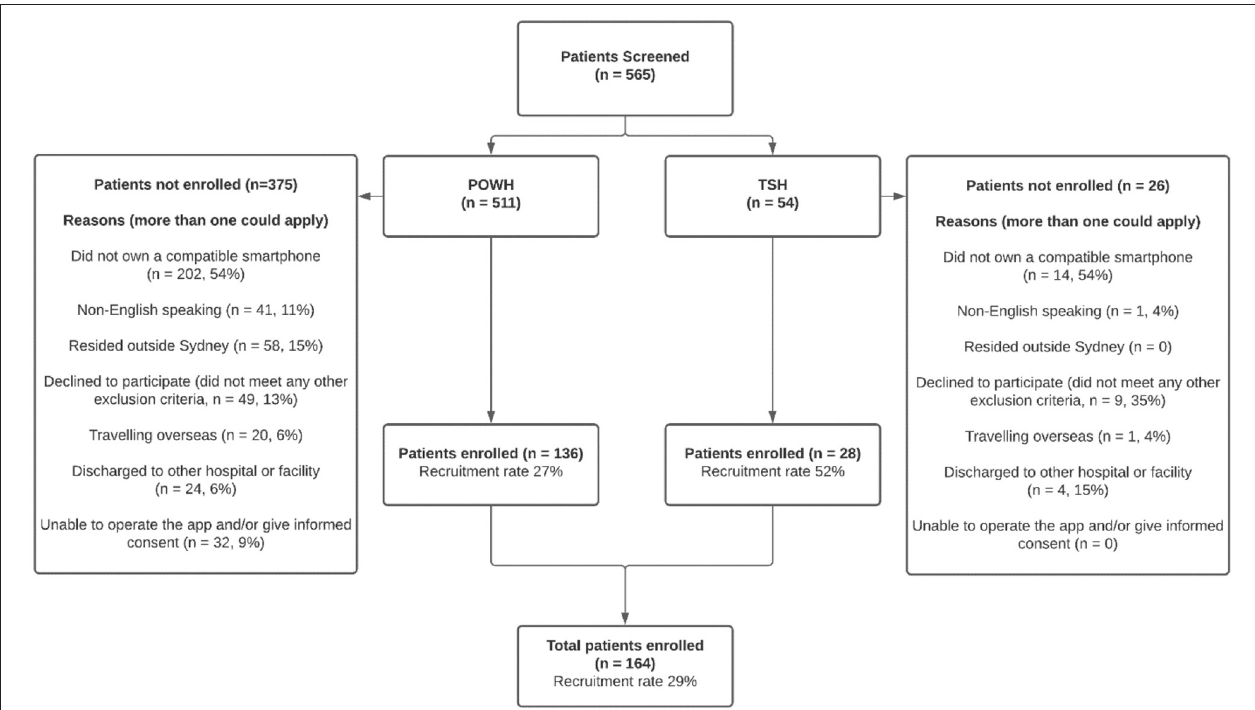
FIGURE 2 | Recruitment patterns between sites. POWH, Prince of Wales Hospital; TSH, The Sutherland